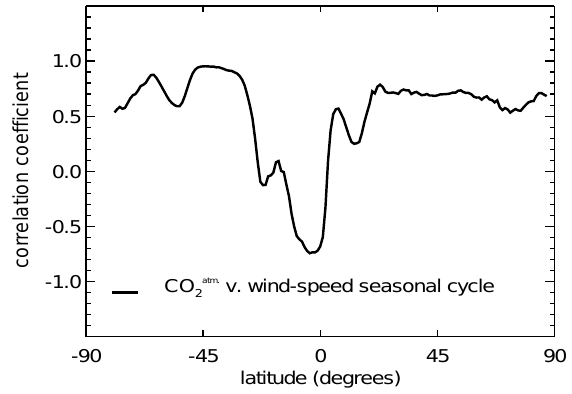
Fig. 8. Correlation coefficient between average monthly latitudi- nally averaged wind-speeds and CO atm concentrations, as simulated 2 in the fully coupled Earth System Model pre-industrial simulation.